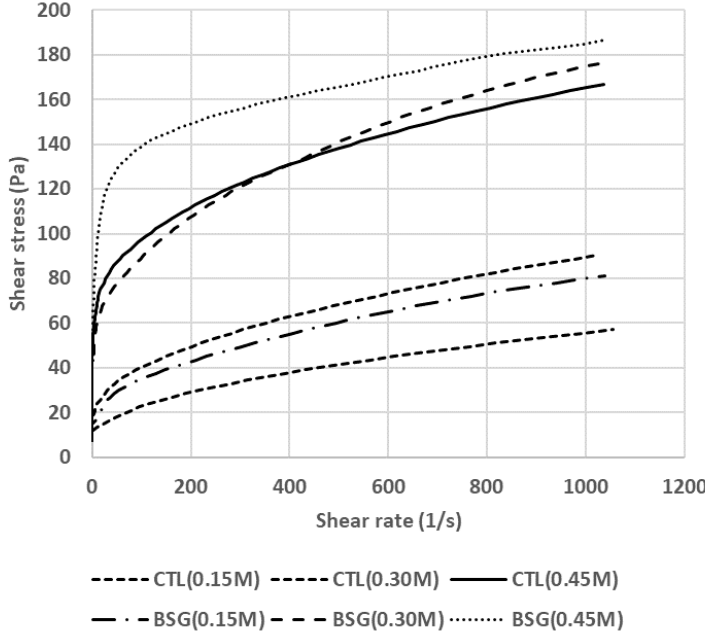
Figure 1. Viscosity of myofibrillar protein mixtures with basil seed gum at different salt concentrations. Treatments: CTL(0.15 M), myofibrillar protein mixtures (MP) without basil seed gum (BSG) at 0.15 M salt concentration; CTL(0.30 M), MP without BSG at 0.30 M salt concentration;